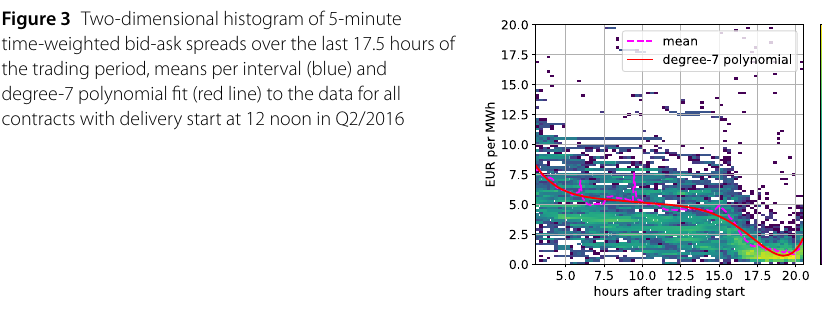
contracts with delivery start at 12 noon in